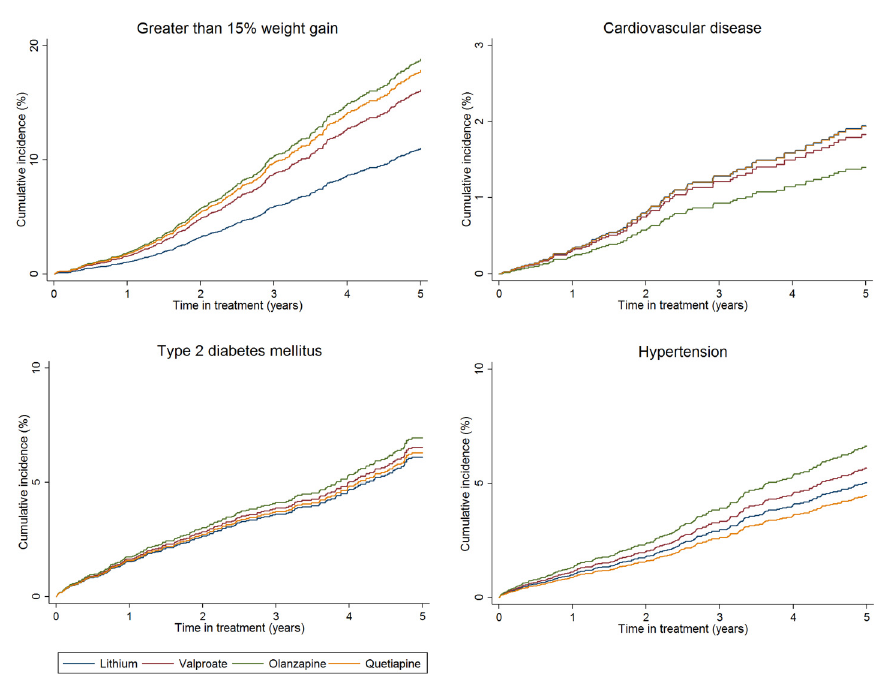
Fig 3. Cumulative incidence estimates of adverse metabolic event rates. From PS and age adjusted competing-risks regression. Note differences in scale of y -axis for each plot.